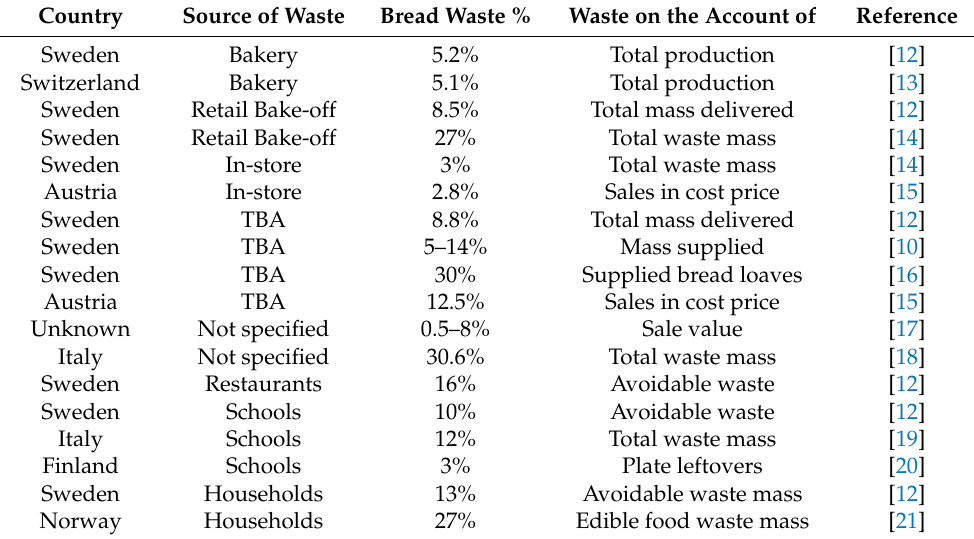
Table 2. Information on bread